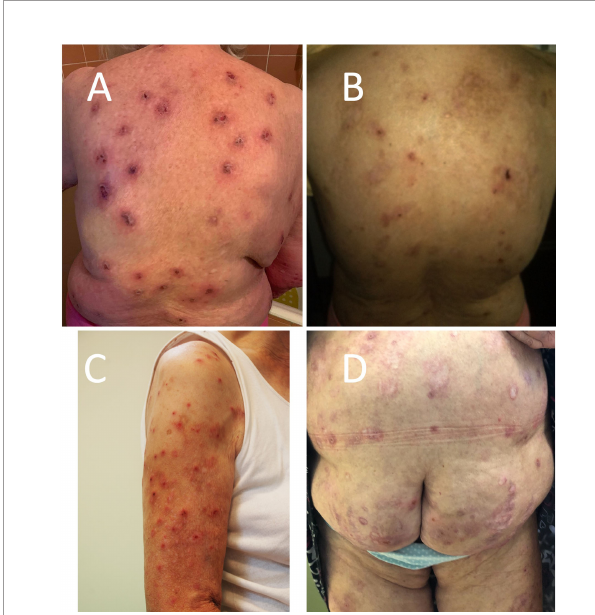
FIGURE 2 | Clinical and immunological features of patient 4 (P4): (A) gingivitis, (B) scarring conjunctivitis of the left eye, and (C) disseminated nodules located on the trunk. FOAM-LSCM of patient ’ s oral mucosa: (D) linear IgG deposits (green color) localized below laminin-332 (red color) and (E) above collagen type IV (red color) at the